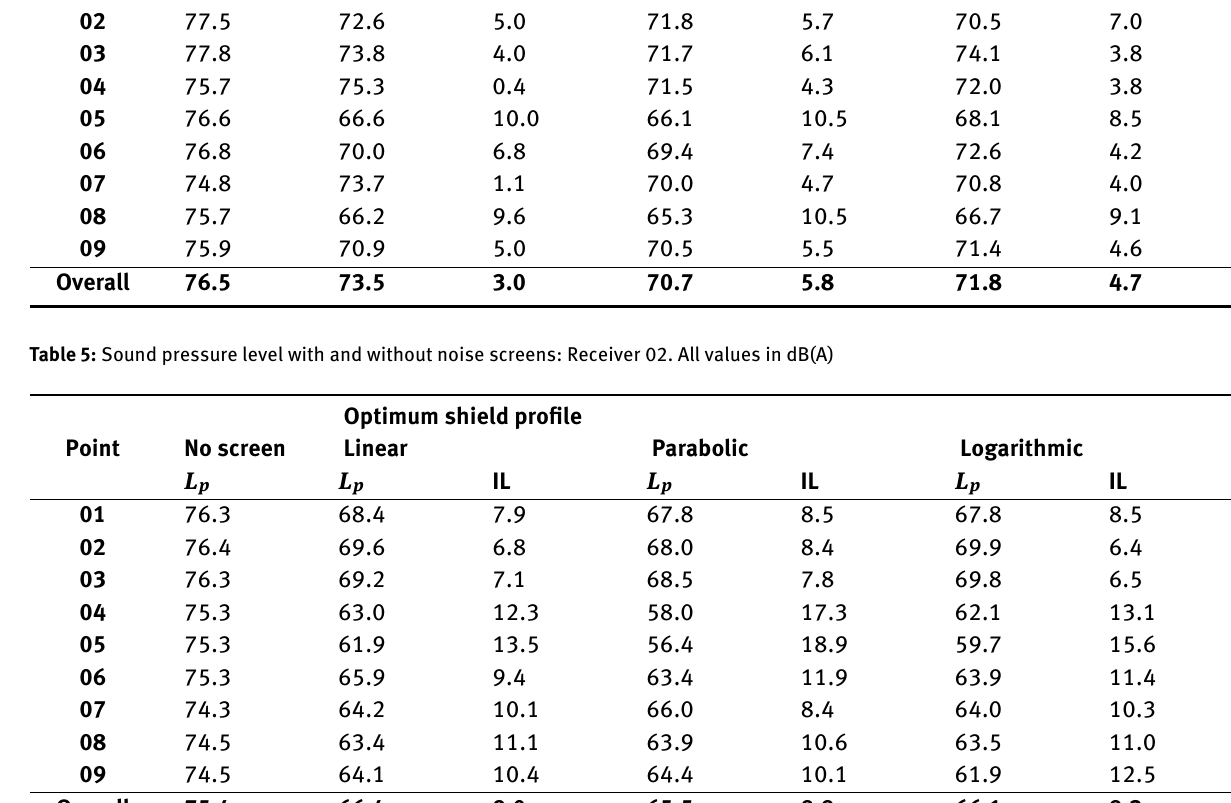
the right-hand side of the receiver, corresponding to the points 01, 04 and 07 (Figure 13), from the noise coming from the southern end of the street. Consequently, in these points the attenuation is very low, ranging from 0 dB to 1.1 dB (Table 4), which penalises severely the overall effective- ness of the